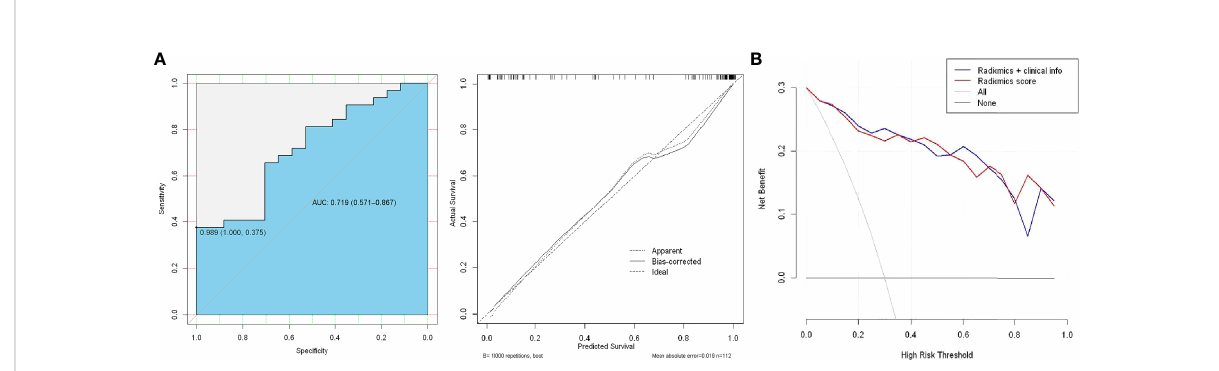
FIGURE 6 (A) ROC analysis of the prediction model using the radiomic nomogram and decision curve analysis of the radiomics model. The y-axis represents net bene fi t. (B) The red and blue lines represent the radiomic nomogram and radiomic nomogram and clinical combination,